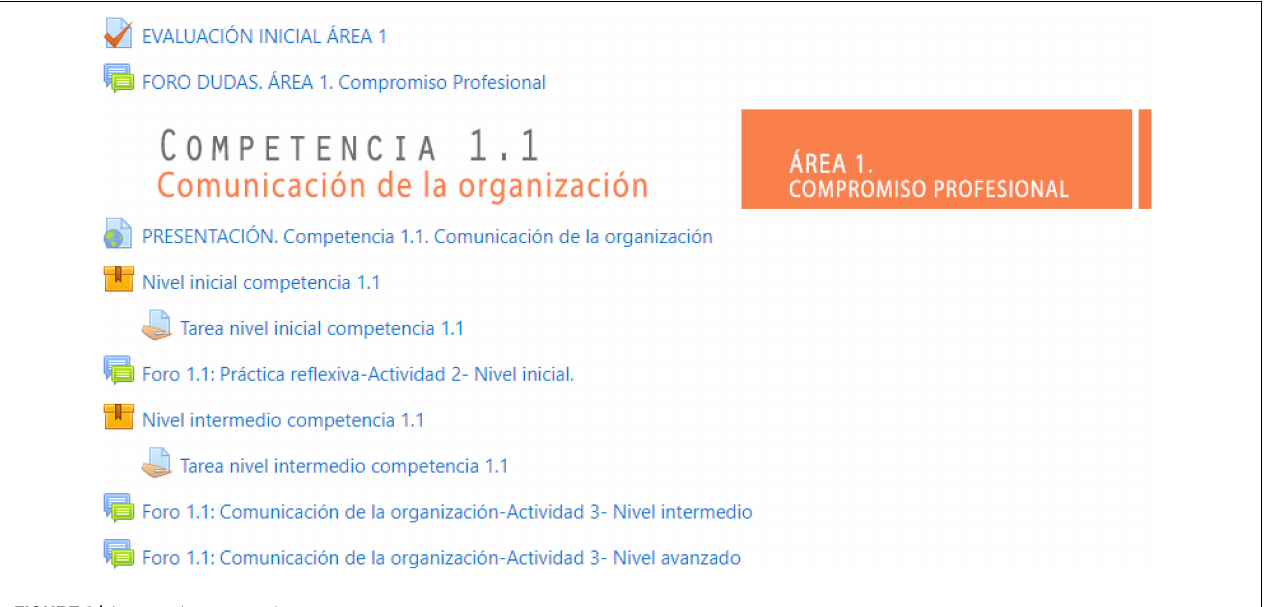
FIGURE 3 | Areas and competencies.